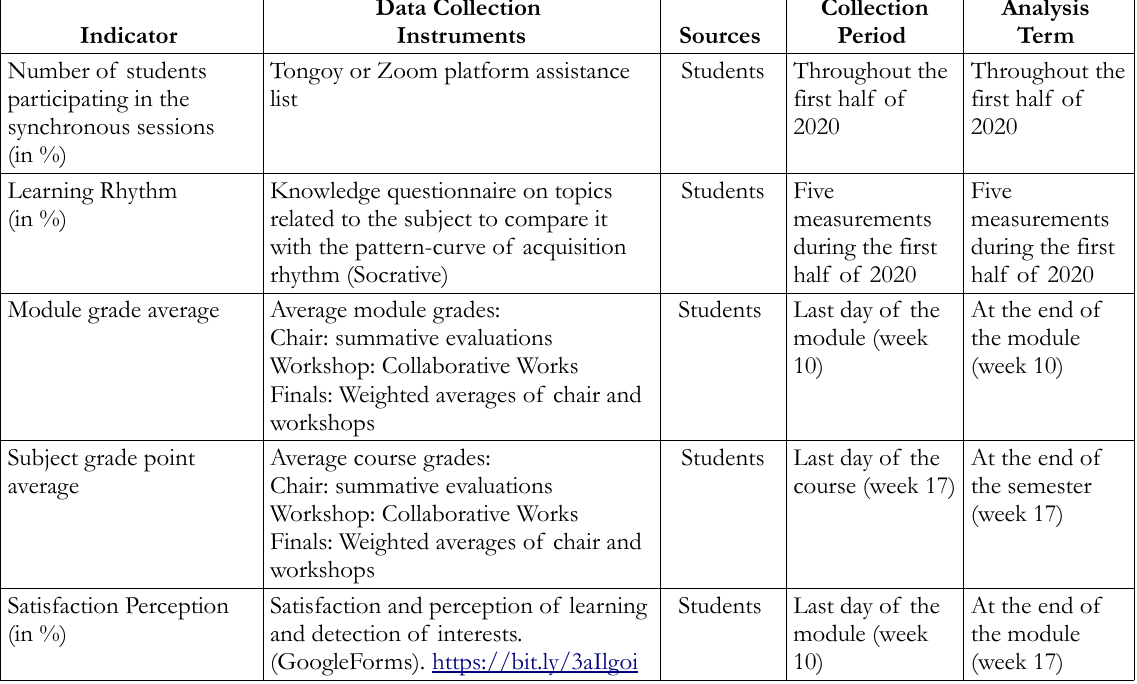
Table 3. Data collection planning, sources, and schedule with